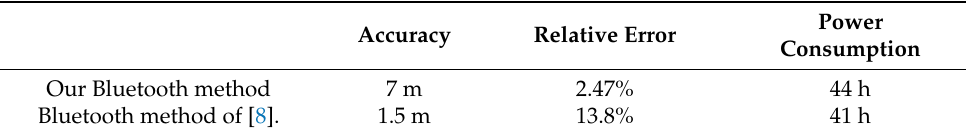
Table 15. Comparison between our method and the method used in